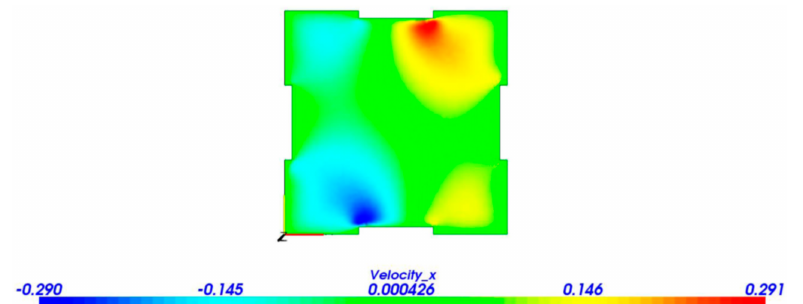
Figure 16. The velocity distribution